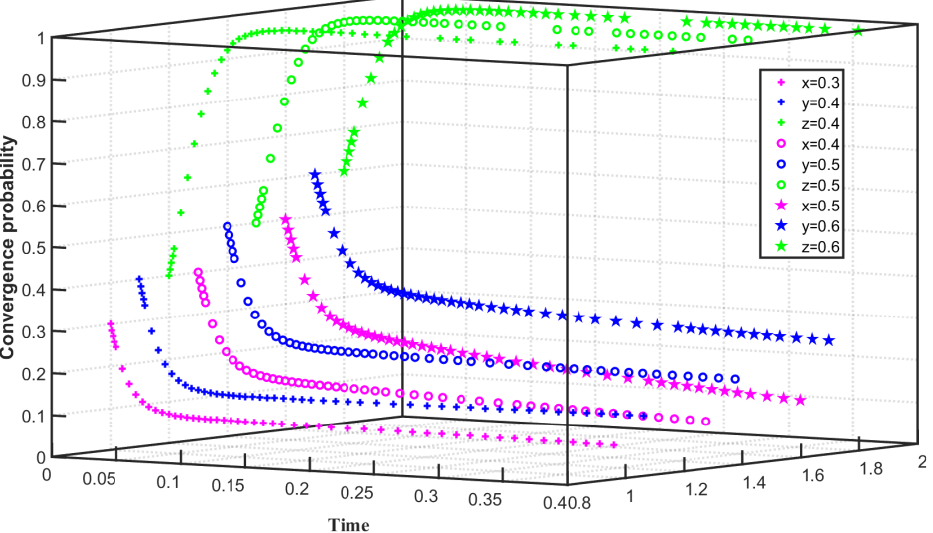
Figure 3. Evolution path of tripartite game system under high emission reduction cost and low regulation cost.